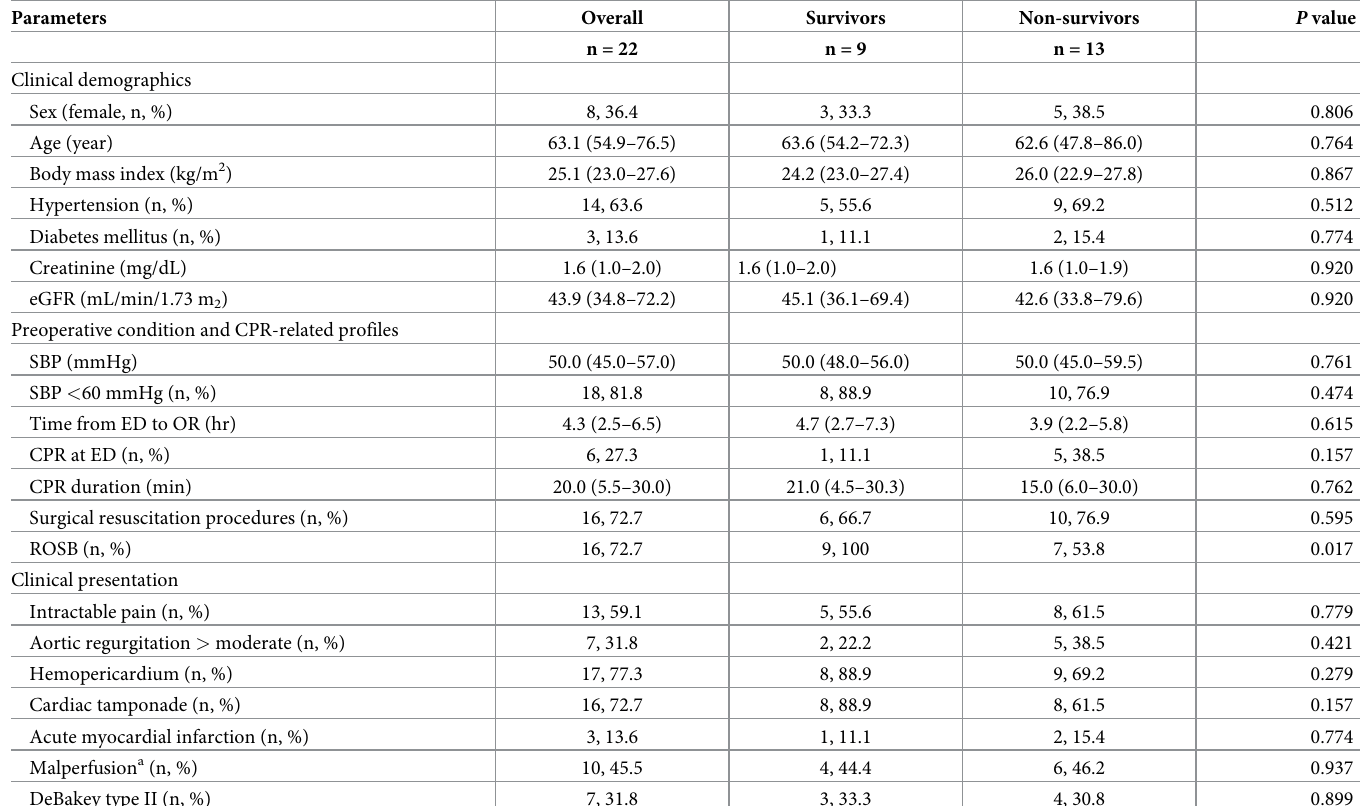
Table 2. Preoperative characteristics according to the patient